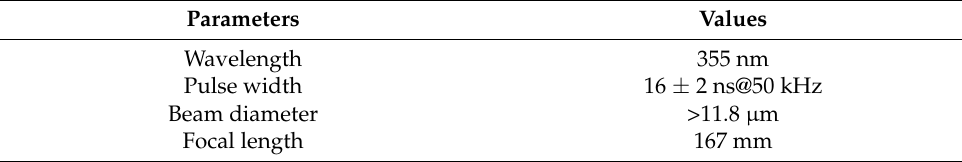
Figure 1. The Schematic diagram of the laser processing of PET film ( a ), and the processing quality evaluation ( b ) of different features (hole (i) and kerf(ii)). Table 1. The specific parameters of laser processing